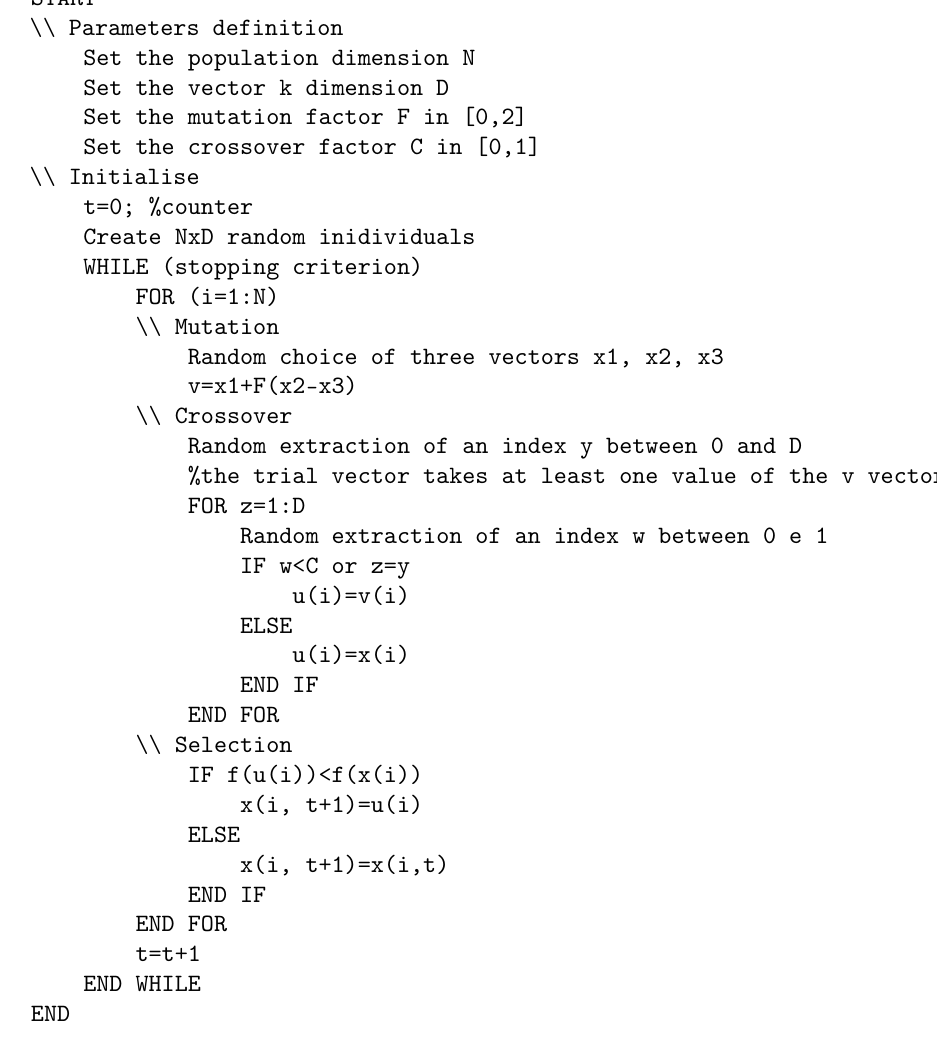
Figure 3. Pseudo-code for DE algorithm, as taken from